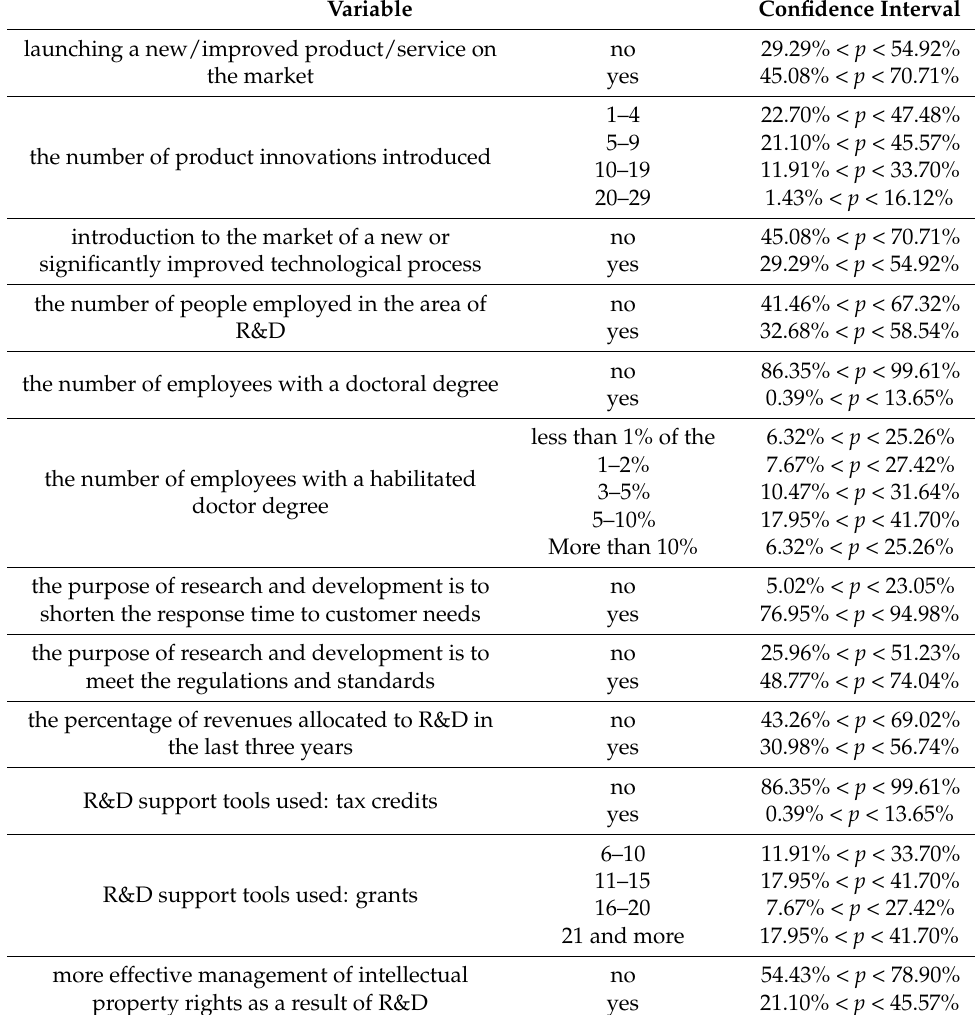
Table 4. Confidence intervals for the structure